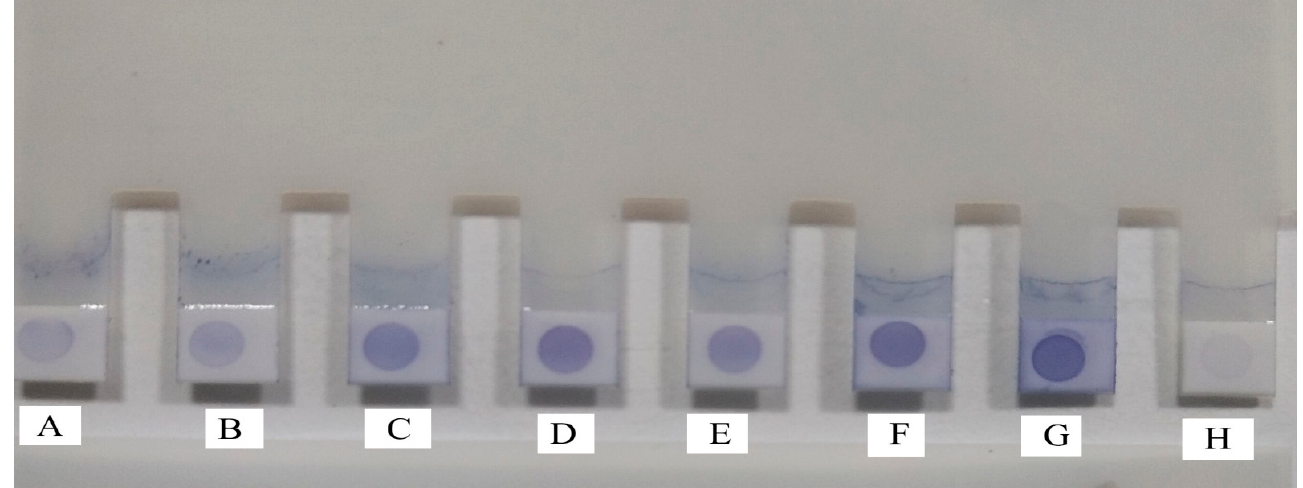
Figure 2. Recombinant LigA/BCon1-5 antigen-based IgM Dot ELISA Dipstick Test (IgM DEDT) for the detection of anti-leptospiral antibodies in human sera. ( A , B ): Low intensity blue dots by human sera which showed seroconversion (0 to ≥ 100); ( C , D ): Moderate intensity blue dots by human sera which showed a four-fold rise in the MAT titre ( ≥ 50 to ≥ 200); ( E , F ): High intensity blue dots by human sera which showed a positive reaction in the single acute MAT (MAT titre ≥ 400); ( G ): Known positive human sera ( H ): Known negative human sera